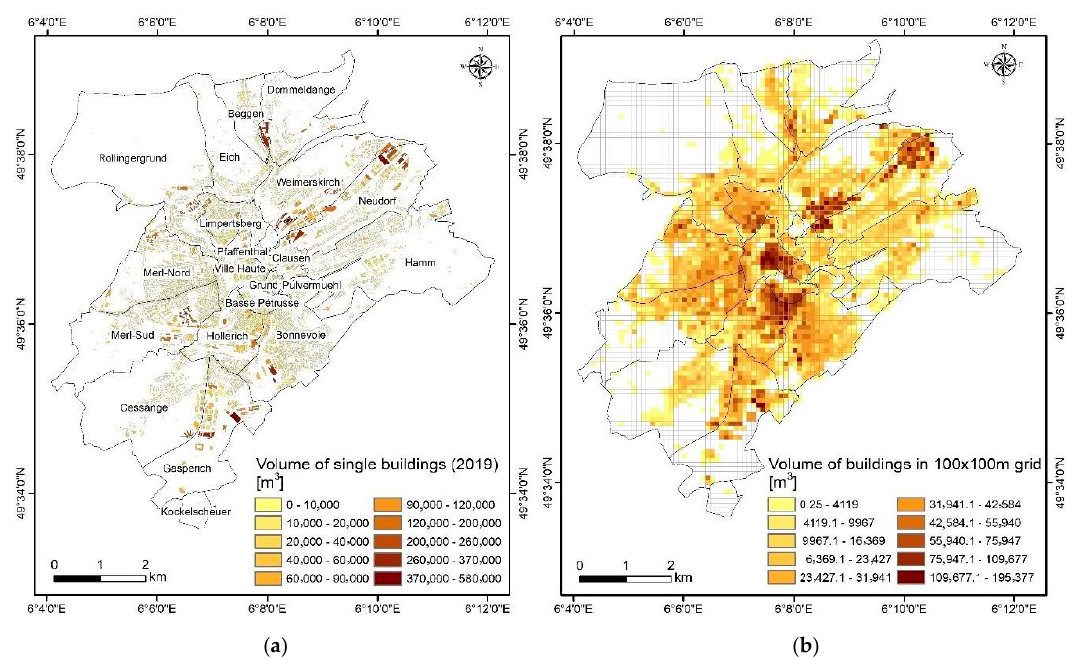
Figure 11. Luxembourg City maps (2019) of ( a ) single buildings volume and ( b ) rasterized map (100 m GSD).